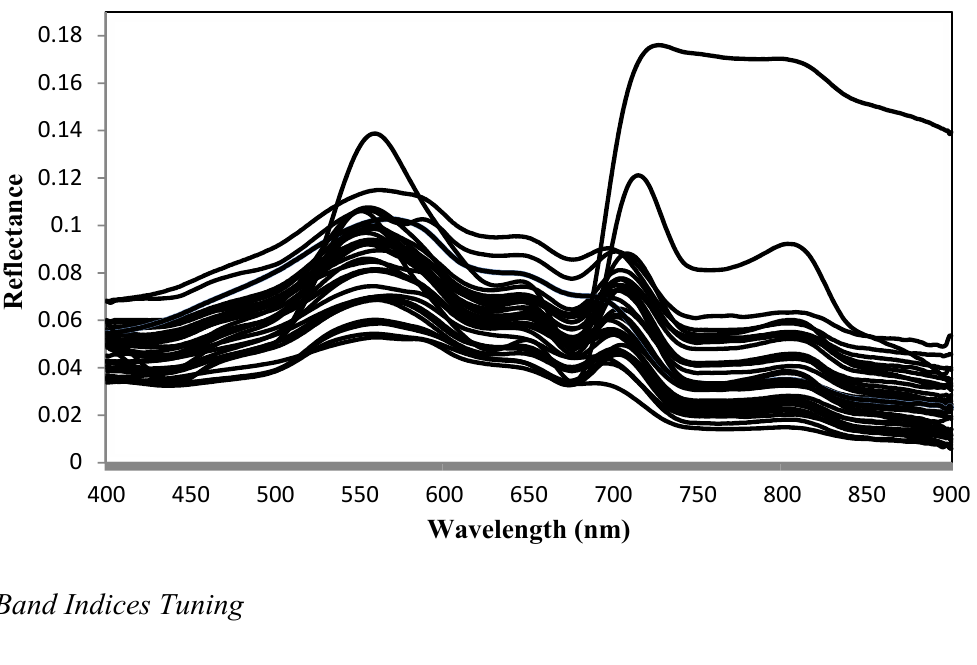
Figure 2. Field spectral reflectance in Dianshan